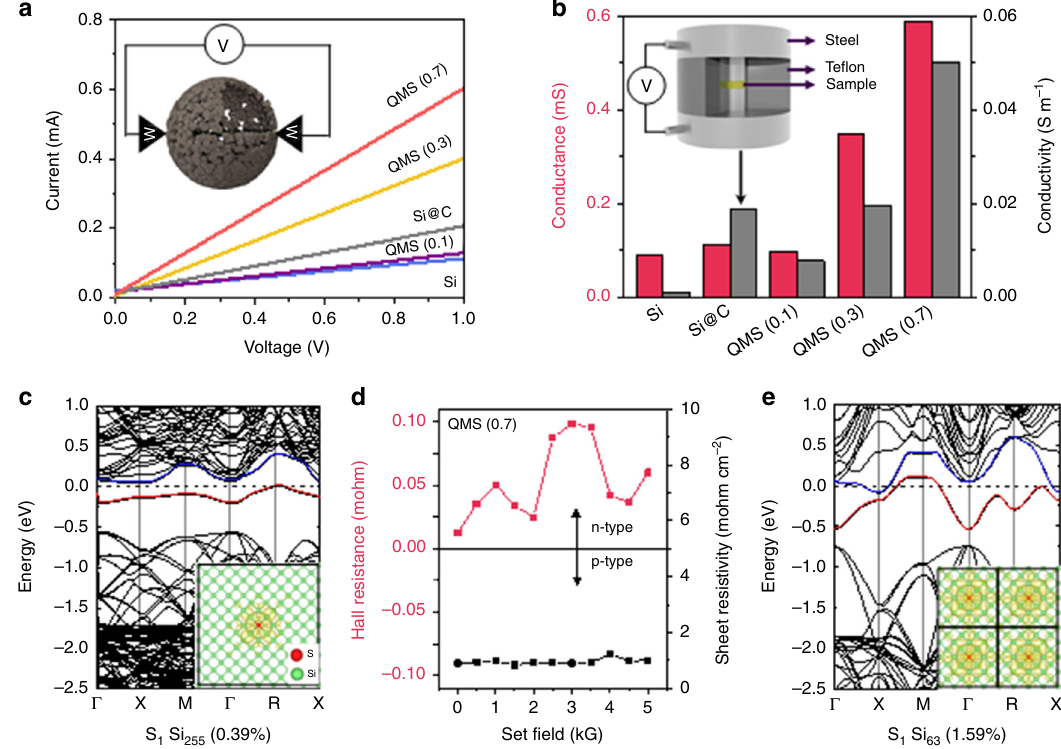
Fig. 2 Metallicity of quasi-metallic silicon. a , b Single-particle I – V plots ( a ) and bulk (pellet) conductivity results ( b ) of bare Si, carbon-coated Si(Si@C), QMS(0.1), QMS(0.3), and QMS(0.7) samples. c , e Calculated band structure of QMS samples with different substitution doping concentrations of ( c ) 0.39%, S 1 Si 255 , and ( e ) 1.59%, S 1 Si 63 . The charge density distribution at these impurity levels (in the insets) is shown in red and blue lines to intuitively illustrate the contribution of Si to the metallic properties. The isosurface of the density is 0.0005e/Å 3 . d Hall effect measurement results of